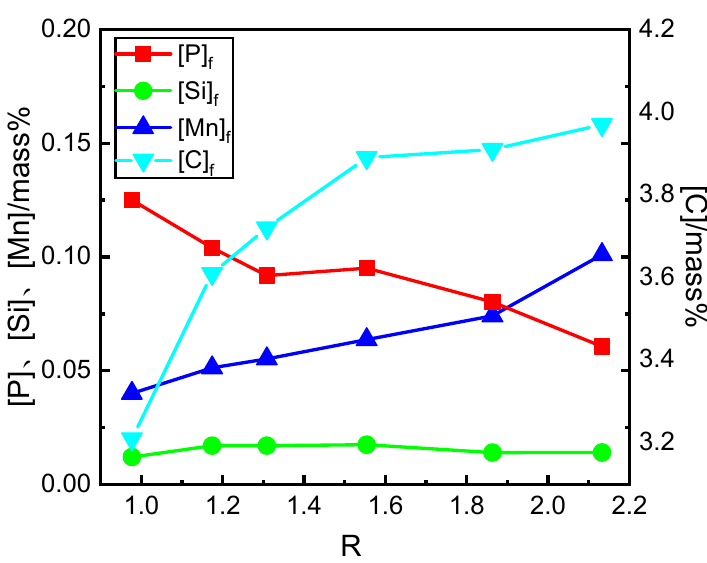
Figure 1. Effect of basicity on the contents of elements in the hot metal after dephosphorization.